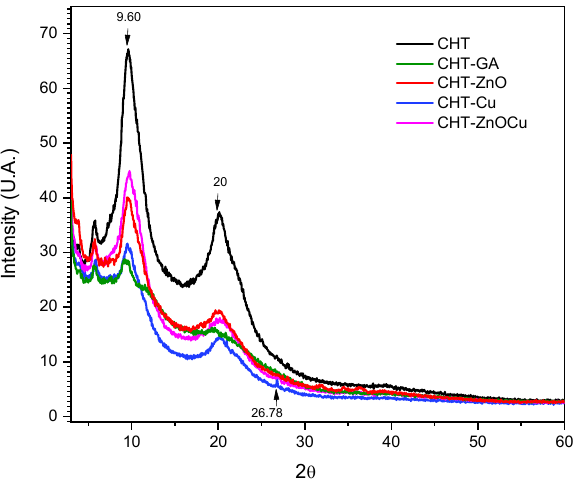
Figure 4. XRD pattern of CHT chitosan crosslinked GA (CHT/GA) chitosan with zinc oxide (CHT/Zn–O), chitosan with copper nanoparticles (CHT/Cu), and chitosan with zinc oxide/copper nanoparticles (CHT/Zn–O/Cu).